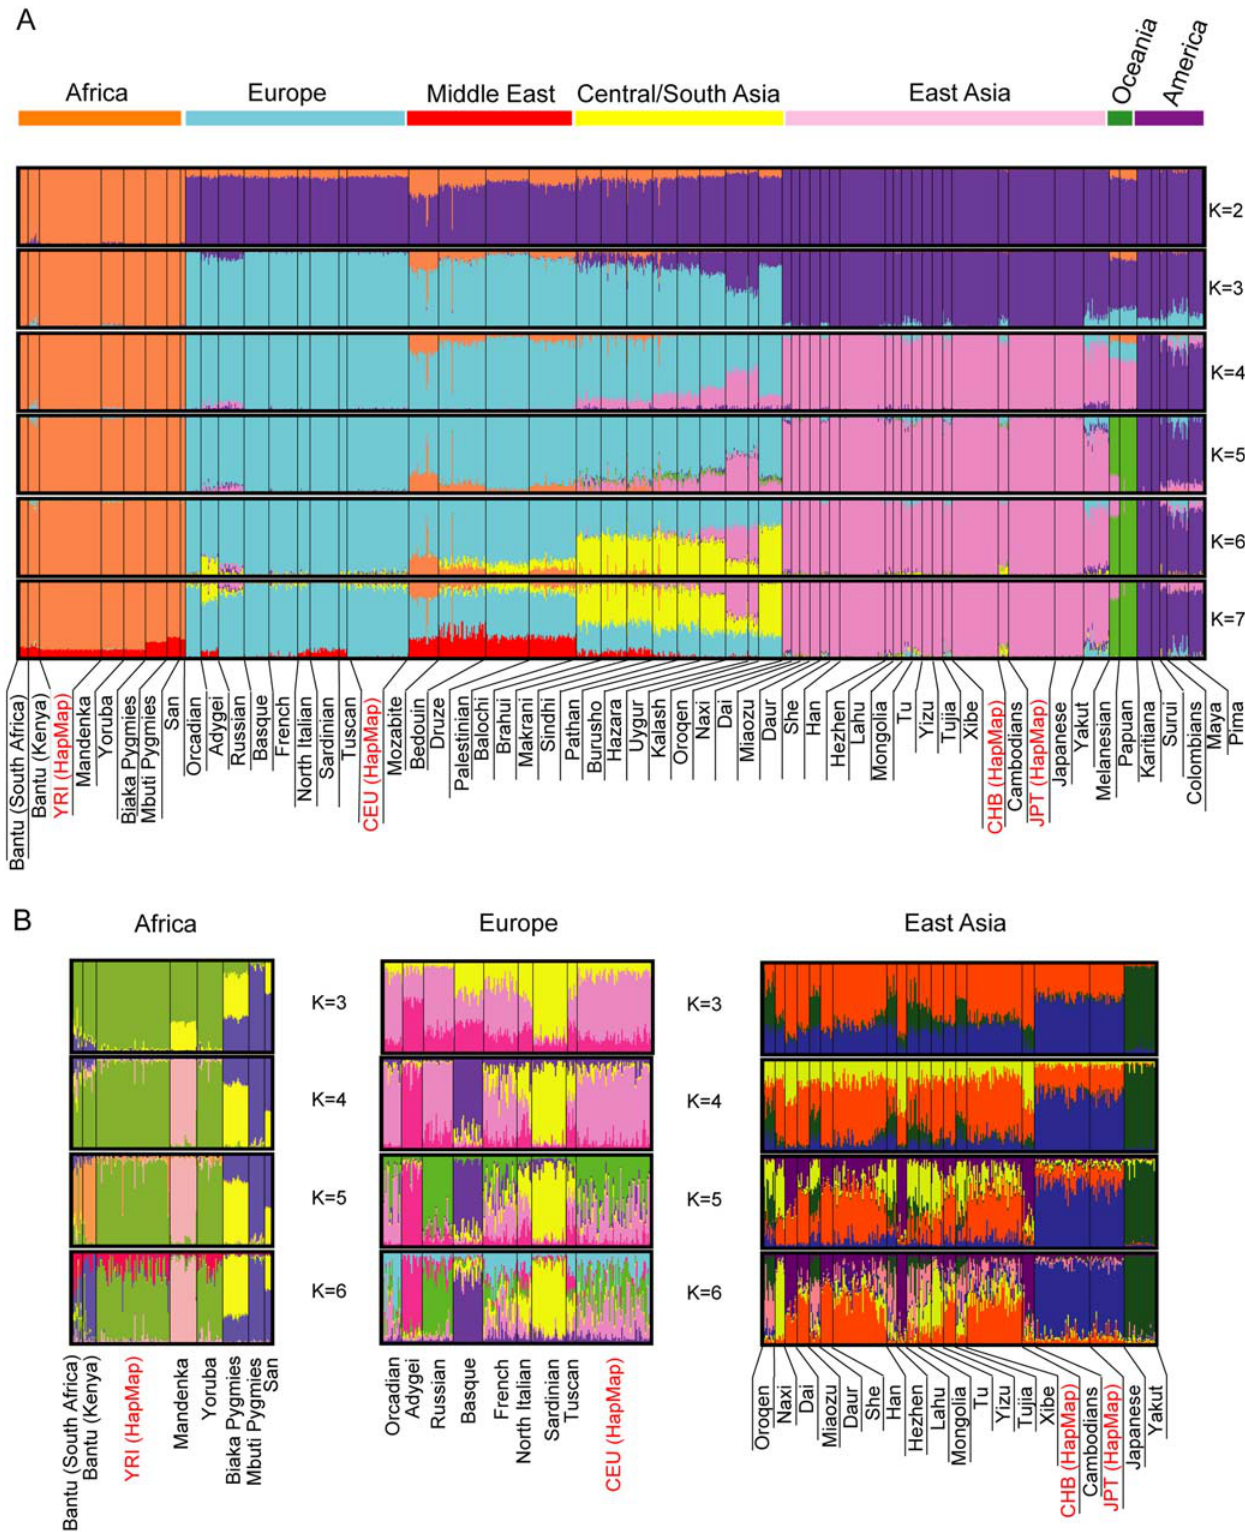
Figure 1. STRUCTURE analysis of the HapMap and HGDP-CEPH panels using 5,254 unlinked SNPs. A. Full dataset. B. Subsets of the panels from restricted geographical regions.